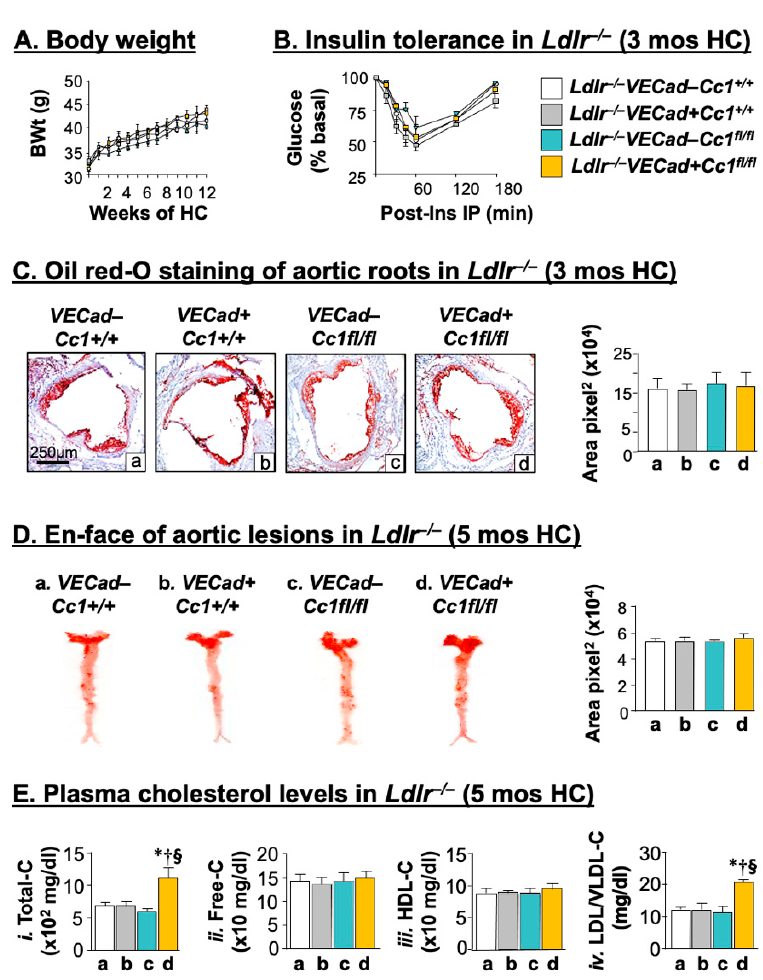
Figure 1. Metabolic phenotyping and morphologic analysis of aortic lesions in mice on the Ldlr − / − background. Ldlr − / − VECad+Cc1 fl/fl mice and littermate controls (n ≥ 5/genotype) were fed HC for 3 months. ( A ) Body weight gain during the feeding period. ( B ) The mice were injected intraperitoneally with insulin (0.75 U/kg BW) to determine glucose clearance 0–180 min post-injection [ Ldlr − / − VECad–Cc1 +/+ (white), Ldlr − / − VECad+Cc1 +/+ (grey), Ldlr − / − VECad–Cc1 fl/fl (teal), and Ldlr − / − VECad+Cc1 fl/fl (yellow)]. ( C ) Aortic root sections were analyzed by Oil red-O (ORO) staining and the stained areas measured in pixel 2 using Image J. Values were expressed as mean ± SEM and presented in the accompanying graph [ Ldlr − / − VECad–Cc1 +/+ (a, white bar), Ldlr − / − VECad+Cc1 +/+ (b, grey bar), Ldlr − / − VECad–Cc1 fl/fl (c, teal bar), and Ldlr − / − VECad+Cc1 fl/fl (d, yellow bar)]. ( D ) Atherosclerotic lesions were assessed by ORO-positive lesions on en-face preparation of whole aortae from mice fed HC for 5 months ( n ≥ 5/genotype). Aortae were dissected from the root to the abdomen and opened longitudinally. Representative en-face views of aortic surface lesions are shown. The extent of atherosclerotic lesion was defined as the percentage of total ORO-positive lesion area over the total surface area, measured in pixel 2 , and values (mean ± SEM) were represented in the accompanying graph [ Ldlr − / − VECad–Cc1 +/+ (a, white bar), Ldlr − / − VECad+Cc1 +/+ (b, grey bar), Ldlr − / − VECad– Cc1 fl/fl (c, teal bar) and Ldlr − / − VECad+Cc1 fl/fl (d, yellow bar)]. ( E ) Retro-orbital venous blood was drawn from overnight-fasted mice (as in D) to assess plasma levels of (i) Total cholesterol (–C), (ii) Free-C, (iii) HDL-C, and (iv) LDL/VLDL-C [ Ldlr − / − VECad–Cc1 +/+ (a, white bar), Ldlr − / − VECad+Cc1 +/+ (b. grey bar), Ldlr − / − VECad–Cc1 fl/fl (c, teal bar), and Ldlr − / − VECad+Cc1 fl/fl (d, yellow bar)]. Values were expressed as mean ± SEM. * p < 0.05 vs. Ldlr − / − VECad–Cc1 +/+ ; † p < 0.05 vs. Ldlr − / − VECad+Cc1 +/+ ; and § p < 0.05 vs. Ldlr − / − VECad–Cc1 fl/fl